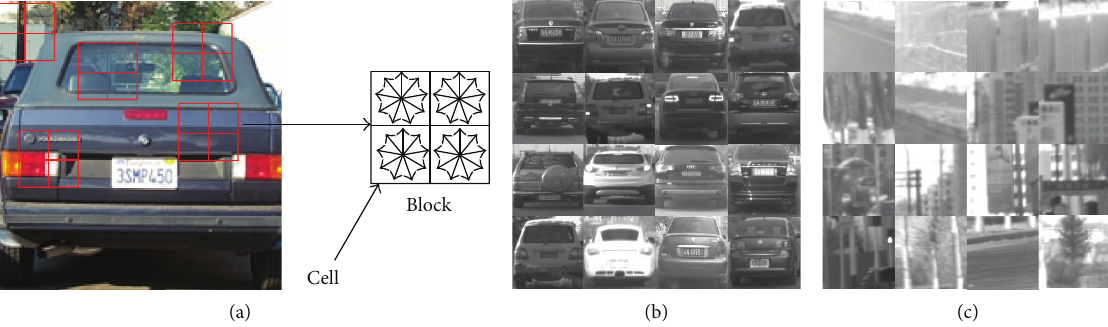
Figure 5: Some samples of training dataset.